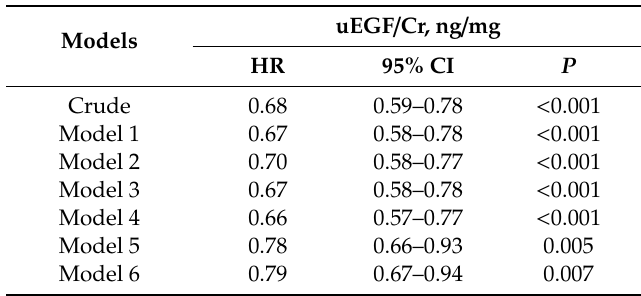
Table 2. Multivariable-adjusted associations between uEGF / Cr and graft failure in 649 RTRs.